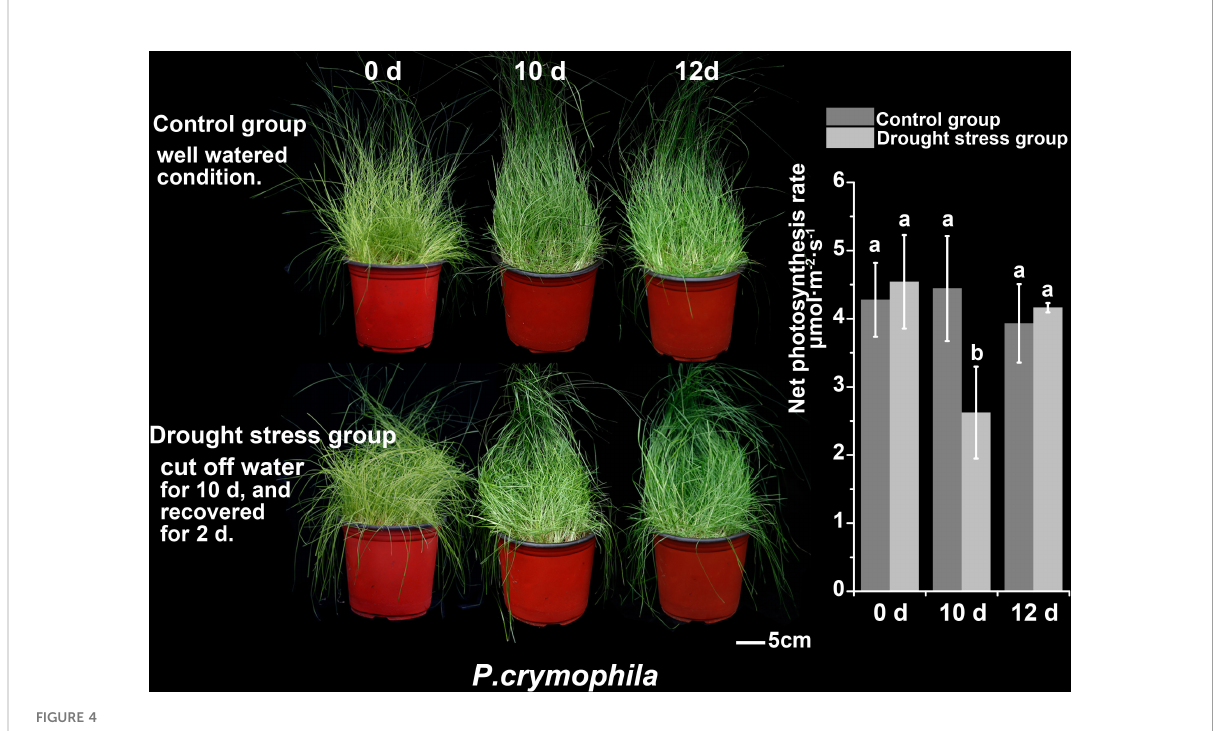
FIGURE 4 The drought stress and recovery of P. crymophila